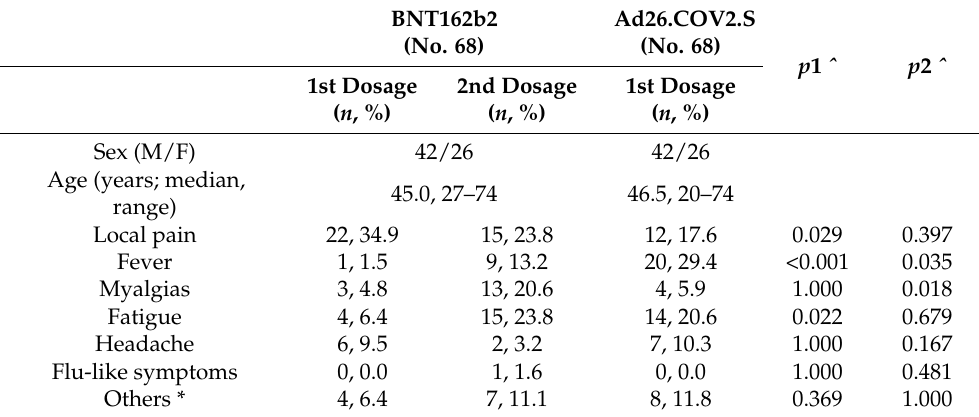
Table 2. Comparison of adverse reactions after vaccination with BNT162b2 and Ad26.COV2.S vaccines.